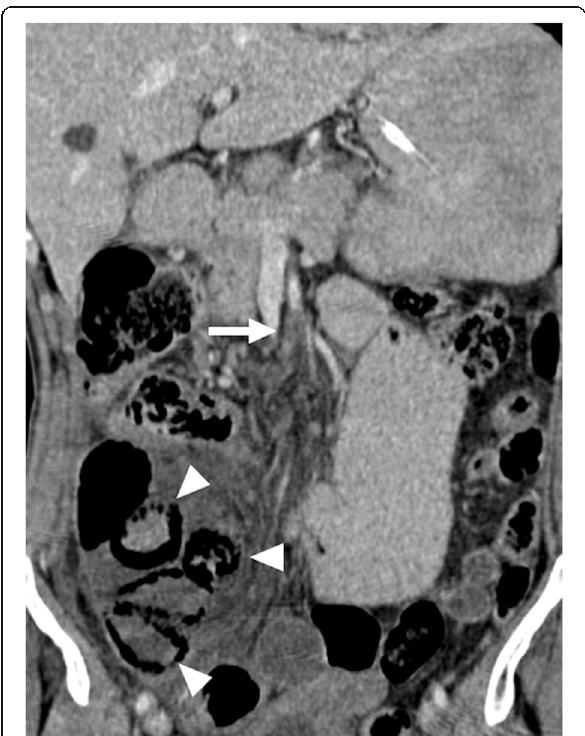
Fig. 21 SMA thrombosis. A 65-year-old male with a previous history of surgically treated intestinal gastrointestinal stromal tumor presented with abdominal pain, distension and tenderness. Coronally reformatted post-contrast CT image demonstrates thrombotic occlusion of SMA (arrow) 4 – 5 cm distal to its origin. Also, note the presence of air within the walls of the small bowel segments consistent with pneumatosis intestinalis (arrowheads). Surgery confirmed infarcted ileal segments and the patient underwent intestinal resection